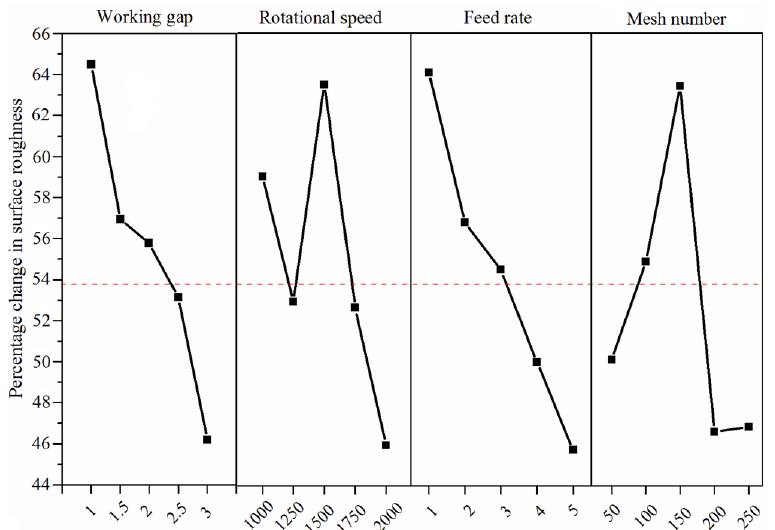
Figure 8. Mean response of process parameter on %Δ𝑅 𝑎 .